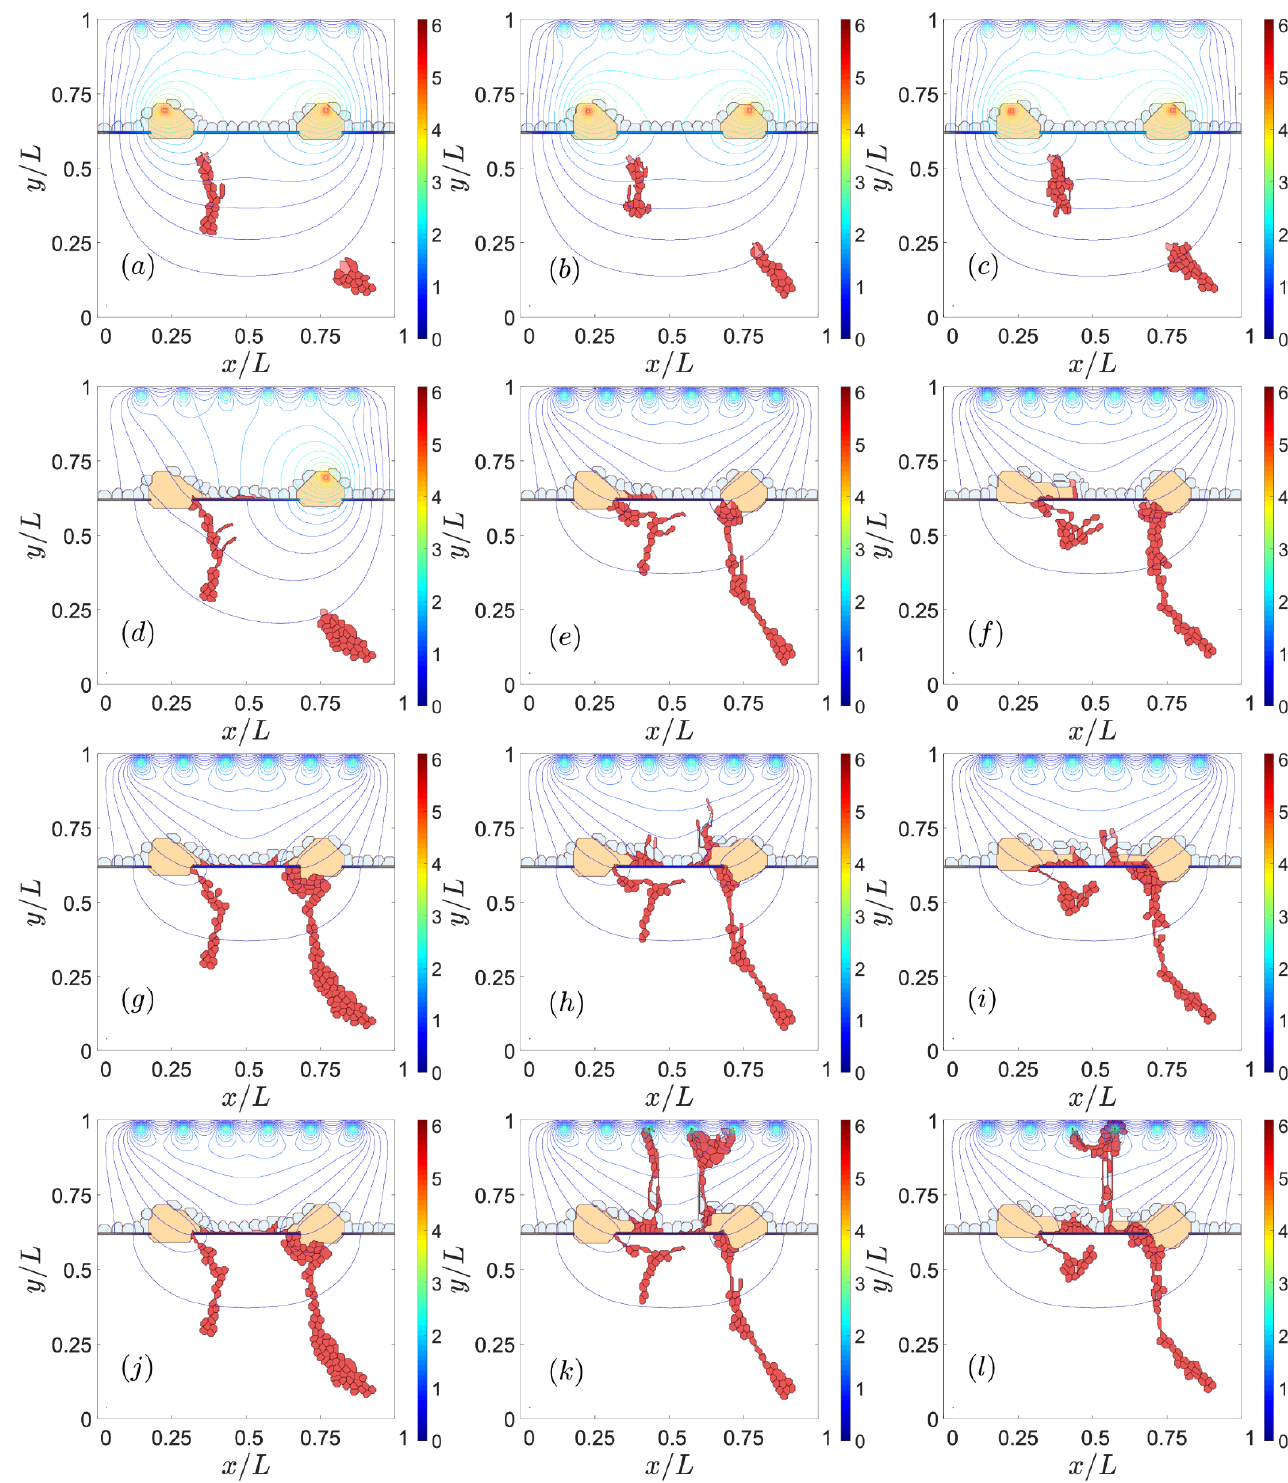
Figure 7. Effect of Jagged and Delta production on CNV. Type 1 CNV for r J = 500 molec/h, r D = 1000 molec/h, snapshots at times: ( a ) 601 MCTS, ( d ) 1601 MCTS, ( g ) 4501 MCTS, ( j ) 9001 MCTS. Type 2 CNV (reference simulation) for r J = 2000 molec/h, r D = 1000 molec/h, snapshots at times: ( b ) 601 MCTS, ( e ) 1601 MCTS, ( h ) 4501 MCTS, ( k ) 9001 MCTS. Type 2 CNV for r J = 2000 molec/h, r D = 7500 molec/h, snapshots at times: ( c ) 601 MCTS, ( f ) 1601 MCTS, ( i ) 4501 MCTS, ( l ) 9001 MCTS. Left column extracted from Supplementary Material: Video S1. Middle column extracted from Supplementary Material: Video S2.